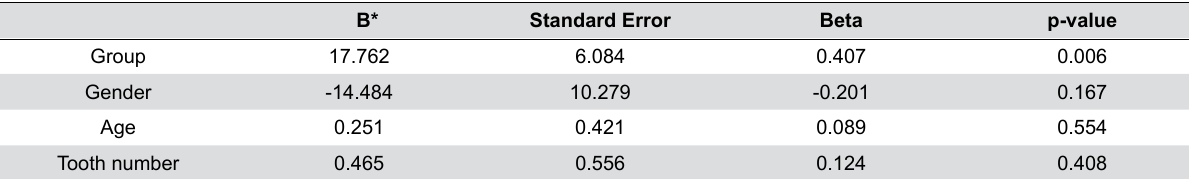
Table 4- Linear Regression Model Findings for Postoperative Pain on Day